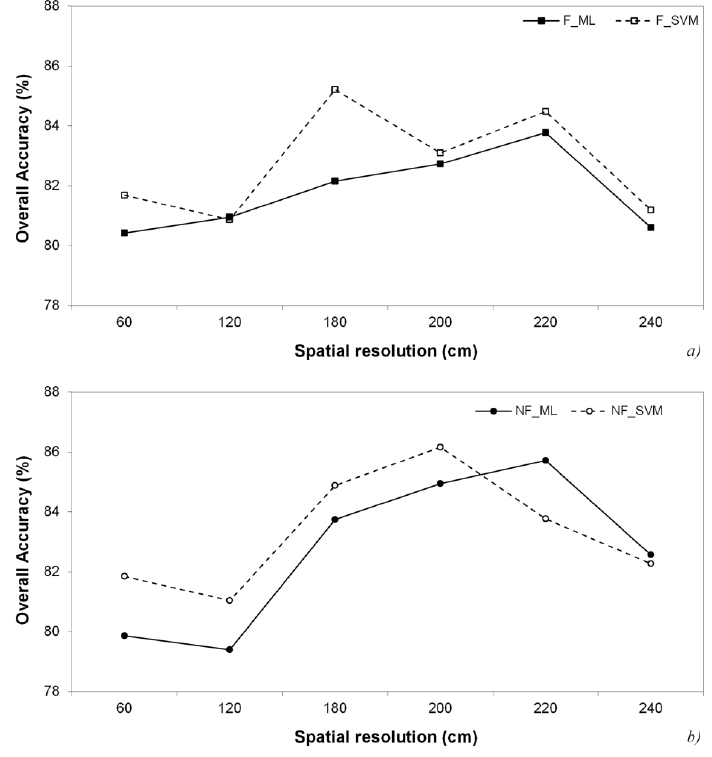
Figure 5. Overall accuracy analysis for the QuickBird 2008 image applying ML and SVM classifires: ( a ) fused image (F); ( b ) non-fused image